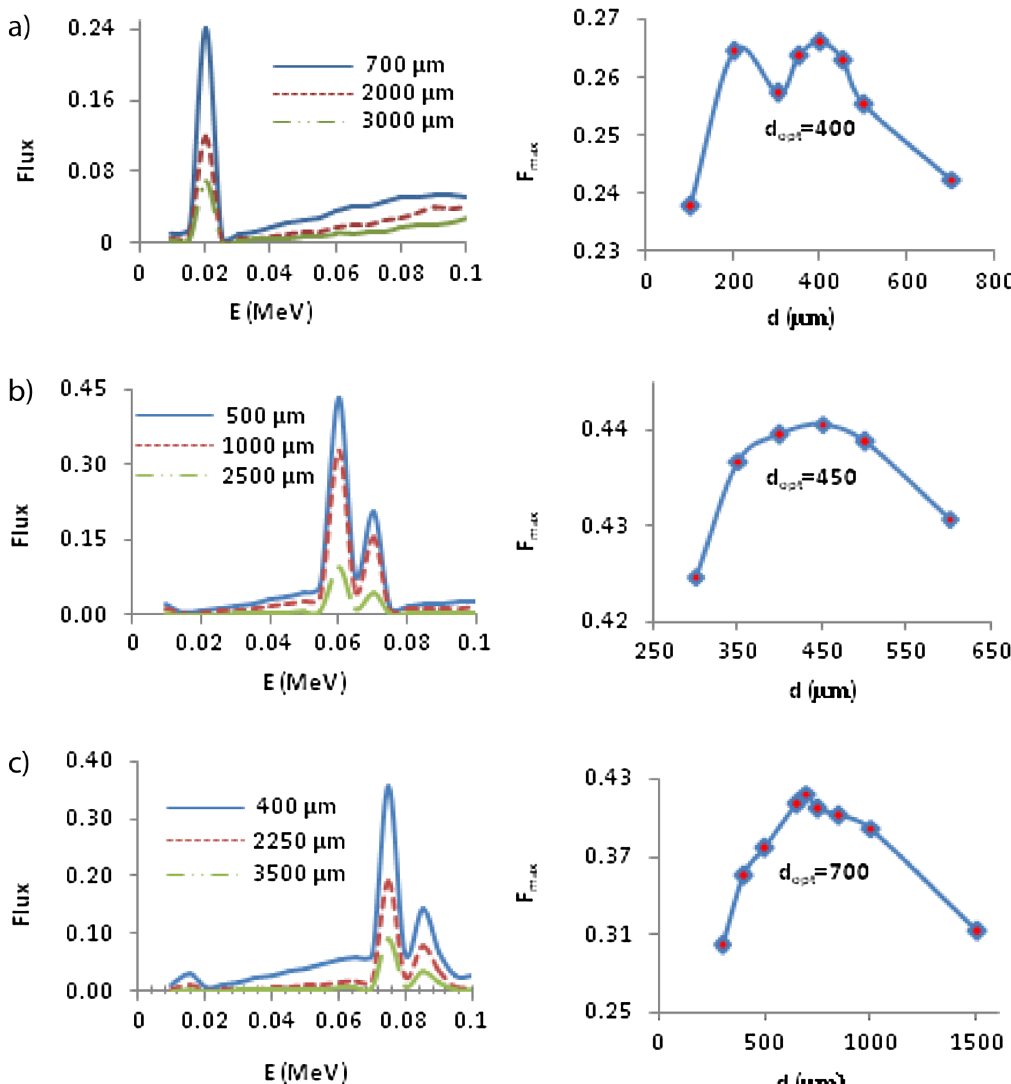
FIG. 4. The x-ray fluxes produced by the q -Maxwellian electron profile versus energy in several thicknesses (left), and the maximum x-ray flux versus thickness (right), for three targets (a) Mo, (b) W, and (c)